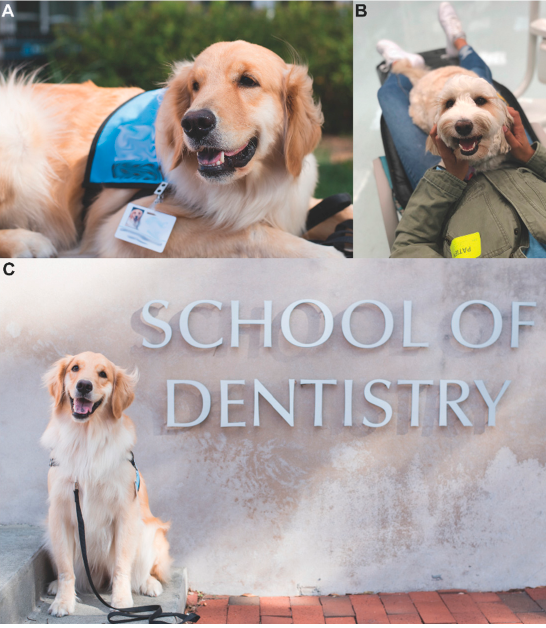
Figure 1. Therapy animals in dental clinics. ( A ) Certified canine therapist, Grayson Siggi. ( B ) Farley Cass comforting orthodontic patients. ( C ) Grayson welcoming visitors, as one of the first dental facility therapy dogs.